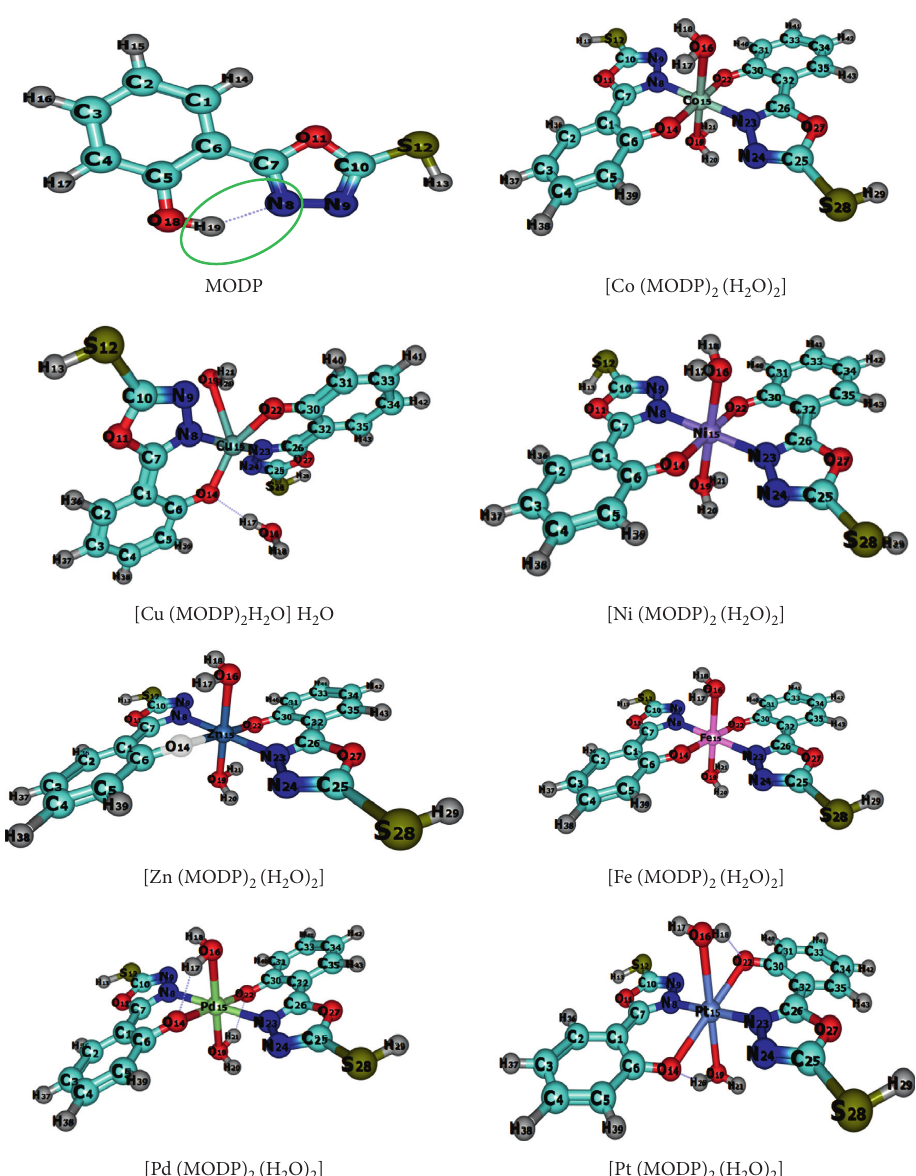
Figure 3: Optimized geometries of MODP and its complexes studied in the gas phase at the DFT/B97-3c level of